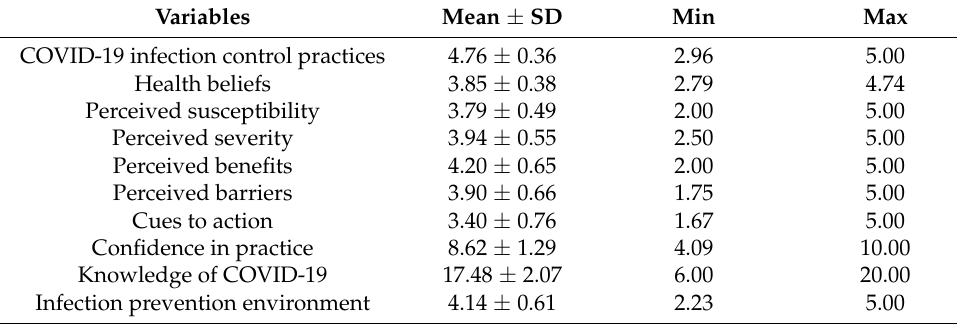
Table 2. Level of variables ( n = 143).